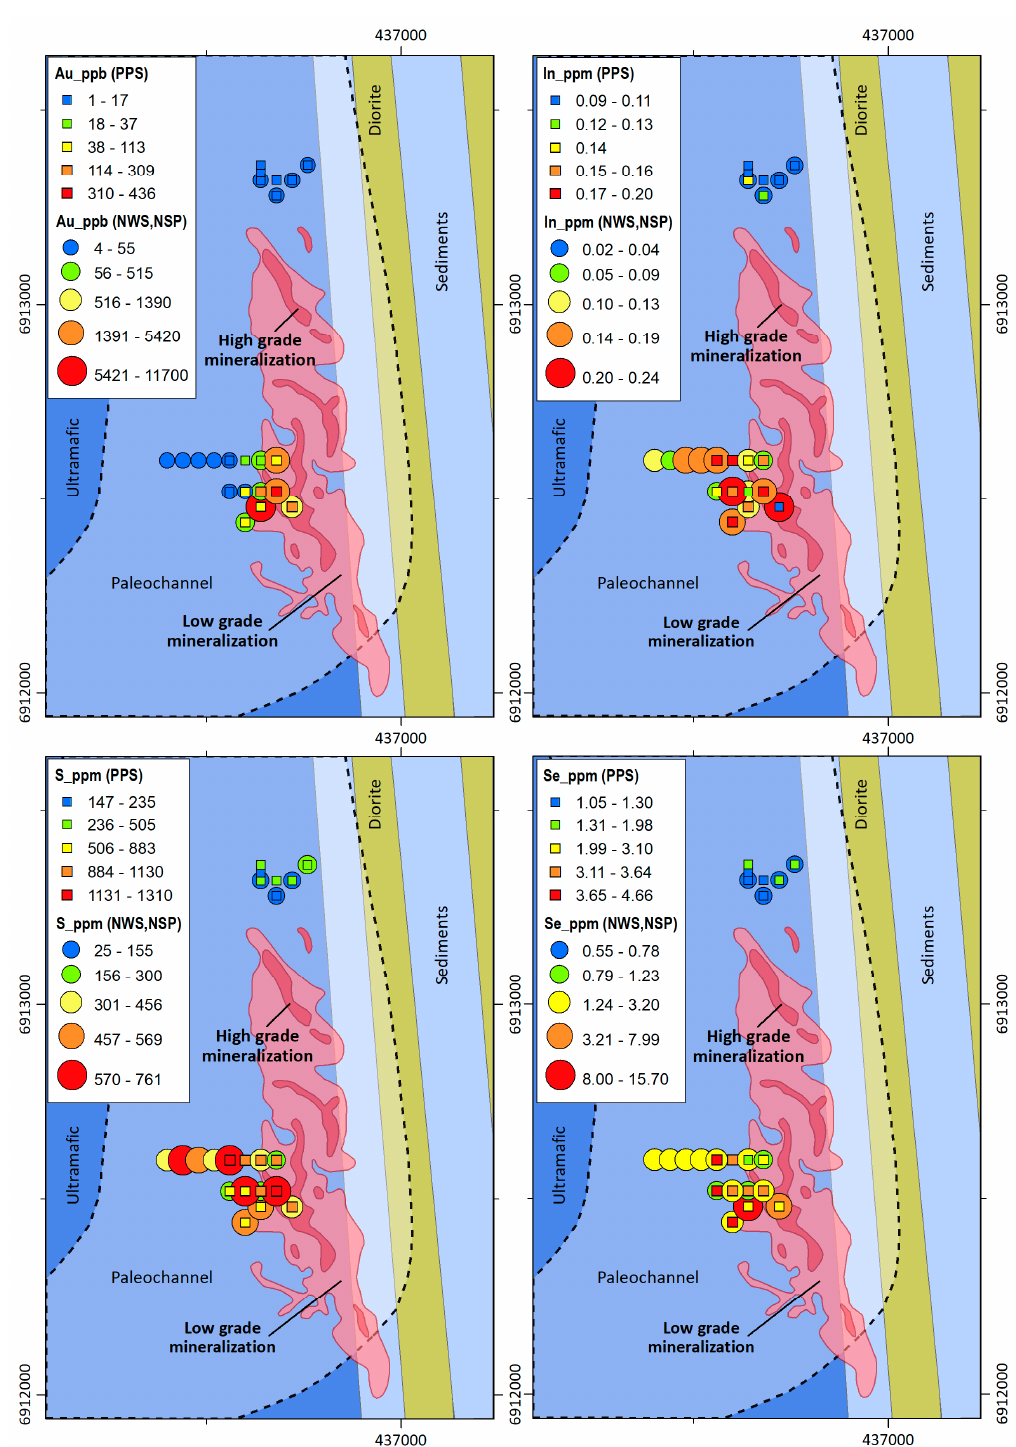
Figure 12. Gold, In, S and Se concentrations in the PPS, NWS and NSP locating the buried mineralization. Due to a very few samples of NSP, NWS and NSP are combined.